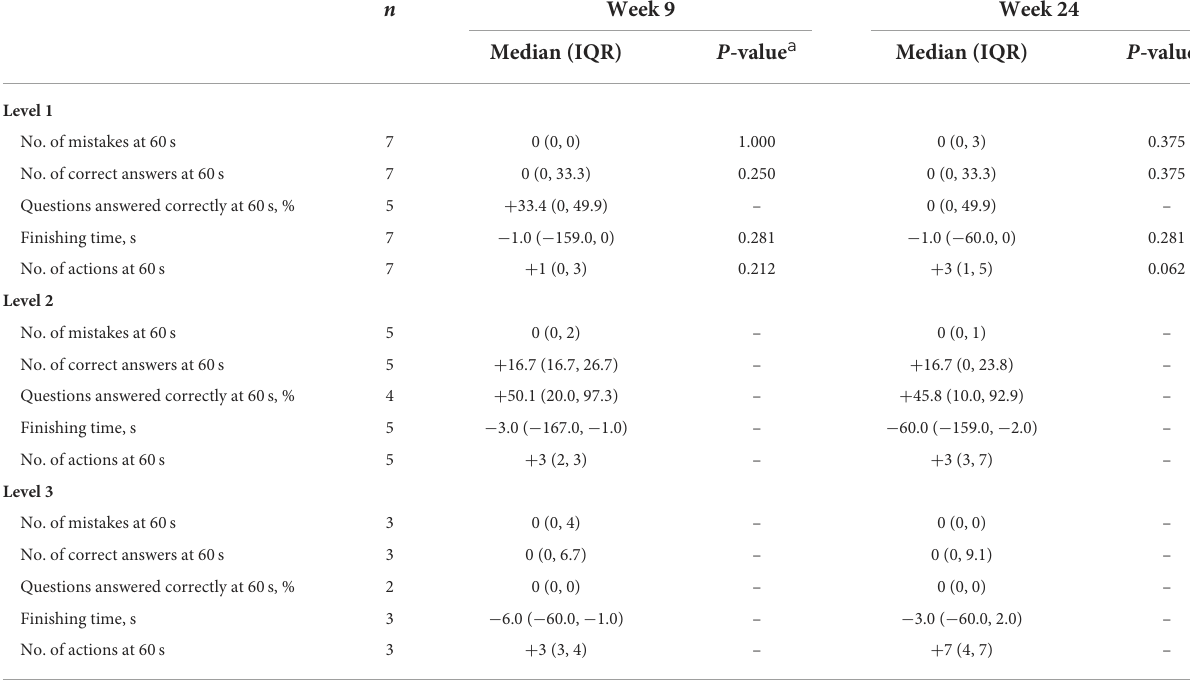
TABLE 3 Rate of change (%) from baseline in matching-pair test parameters at Week 9 and Week 24.